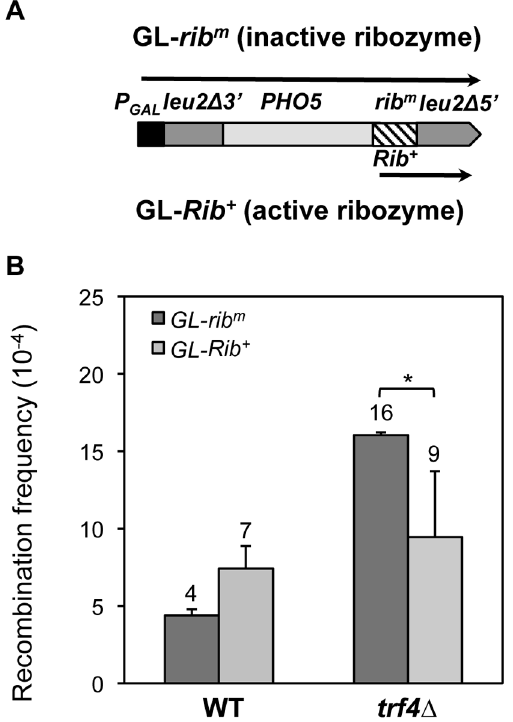
Figure 4. Nascent mRNA-dependency of the hyperrecombina- tion phenotype of trf4 D mutants. ( A ) Direct-repeat recombination systems GL- Rib + and GL- rib m containing the PHO5-Rib + or PHO5- rib m sequences flanked by two truncated copies of LEU2 in direct orientation under the GAL1 promoter. These systems contain respectively an active or inactive 52-bp ribozyme ( Rib ). The rib m system (inactive ribozyme) yields a long transcript, whereas in the Rib + system (active ribozyme) self-cleavage of the PHO5-Rib transcript leads to a shorter mRNA (represented by arrows). ( B ) Recombination frequencies in W303-1A (WT) and TRF4D-C5 ( trf4 D ) cells containing the recombination systems GL- Rib + and GL- rib m . Experiments were performed in 2% galactose to allow expression of the direct repeats. The average median value and SD of 3–4 fluctuation tests are shown. Asterisk indicates statistically significant differences, according to Student’s t-tests (*, R , 0.05).